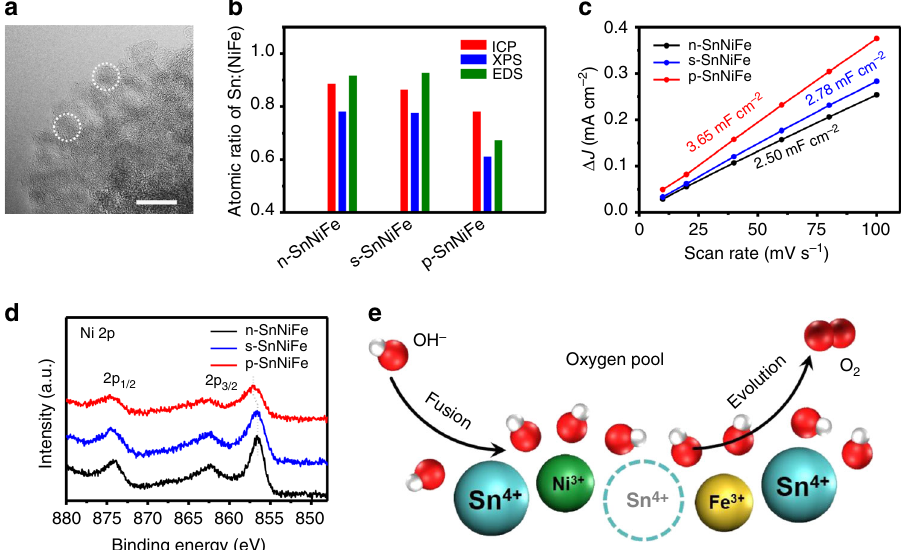
Fig. 4 Evaluation of the p -block regulation strategy. a High-resolution TEM image of p-SnNiFe, exhibiting no obvious difference from n-SnNiFe. b Atomic ratio of Sn:(NiFe) of n-SnNiFe, s-SnNiFe, and p-SnNiFe determined by ICP, XPS, and EDS. c ECSA and d high-resolution Ni 2p XPS spectra of n-SnNiFe, s-SnNiFe, and p-SnNiFe. e Scheme of the proposed oxygen pool model and fusion-evolution OER process. Scale bars, 10 nm ( a